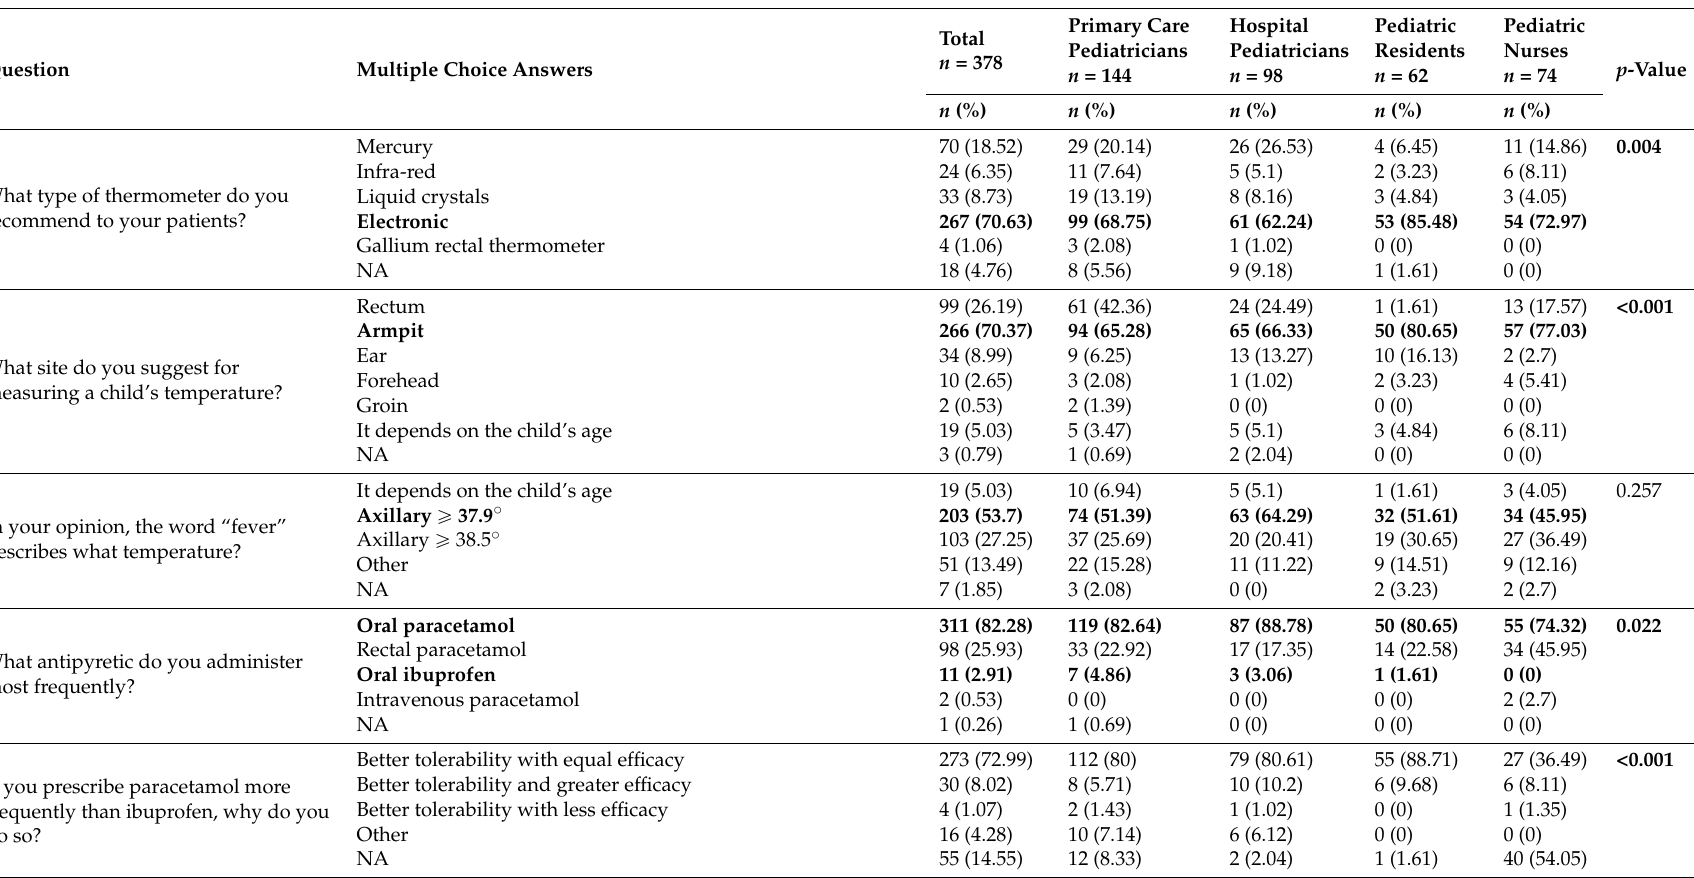
Table 2. Fever management by healthcare